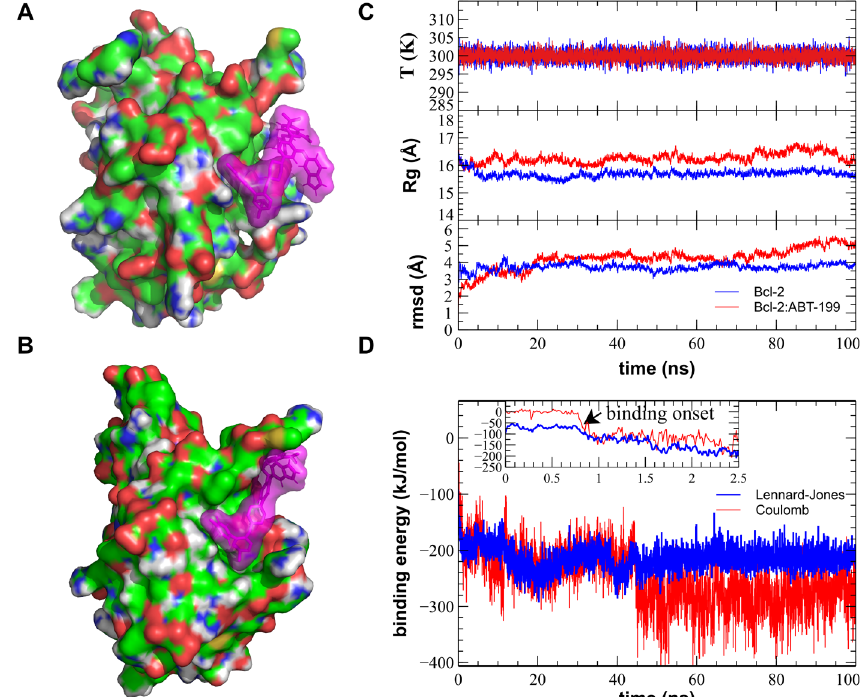
Figure 3. MD simulation of the Bcl-2:ABT-199 interaction produces a successful binding of the ABT-199 to the hydrophobic cleft of the Bcl-2. (A). Sample initial position of the ABT-199 (violet semitransparent spheres) in the proximity of the crystal structure-based Bcl-2 (CPK-colored surface). (B). A representative simulation frame showing the Bcl-2:ABT-199 complex following the binding event and equilibration. (C). Representative curves showing stable evolution of the system temperature (top), Bcl-2 gyration radius (Rg, middle), and root mean square deviation (rmsd, bottom) during the entire duration of the MD simulation. (D). Time dependence of the binding energies (Coulomb force in red and Lennard-Jones potential in blue) during the course of the MD simulation. Note the start of the binding event commencing within the first ns of the simulation, typical of the ABT-199 prepositioned in the close proximity of the BH3 hydrophobic cleft, while the propagation of conformational change induced by this binding and equilibration of Bcl-2 structure continuing for additional ~40 ns. T: